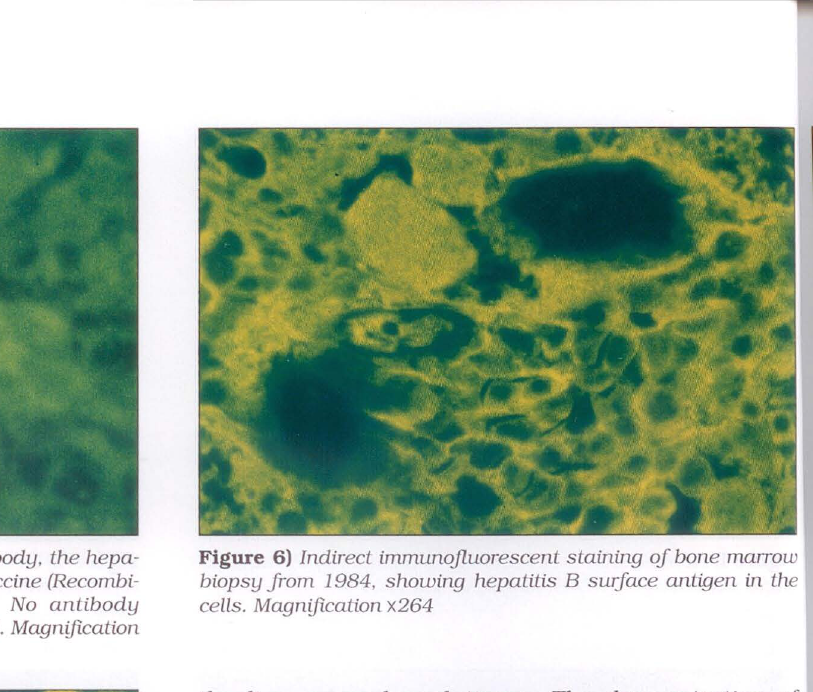
Figure 6) Indirect immunofluorescent staining of bone marrow biopsy from 1984, showing hepatitis B surface antigen in the cells. Magn!ficat1on